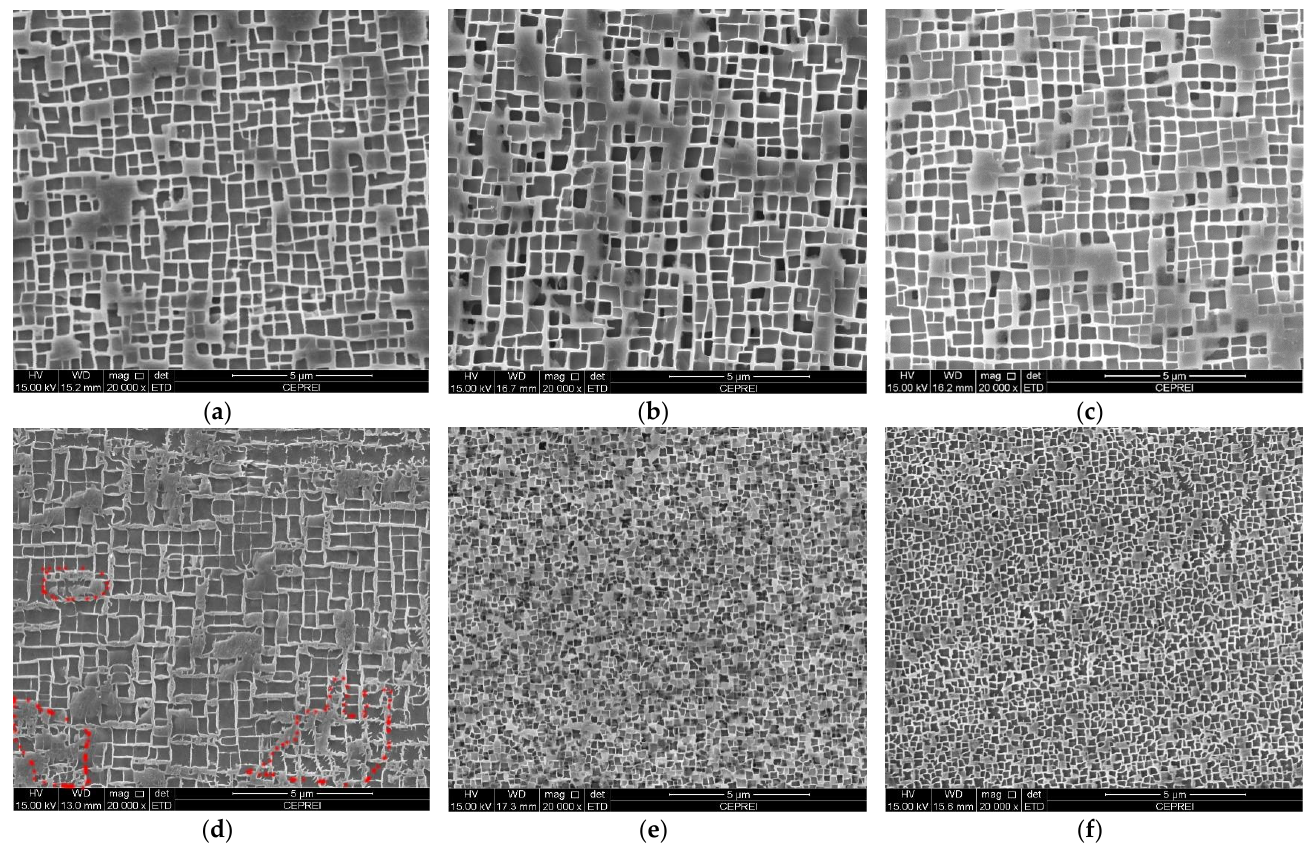
Figure 2. SEM-SE images of the γ / γ ’ phases in the dendrite core regions of the experimental superalloy after overheating at ( a ) 1100 ◦ C/5 min; ( b ) 1100 ◦ C/60 min; ( c ) 1100 ◦ C/120 min; ( d ) 1300 ◦ C/5 min; ( e ) 1300 ◦ C/60 min; ( f ) 1300 ◦ C/120 min. The volume fraction and average size of the γ ’ precipitates in the dendrite core regions were counted after overheating, and the results are listed in Table 1. It is shown that the volume fraction and average size of the γ ’ precipitates were 66.2% and 0.46 µ m, 65.6% and 0.48 µ m, 64.4% and 0.50 µ m after overheating at 1100 ◦ C for 5 min, 60 min, and 120 min, respectively. With the extension of the overheating duration, the volume fraction and average size of the γ ’ precipitates decreased slightly, but was close to that after